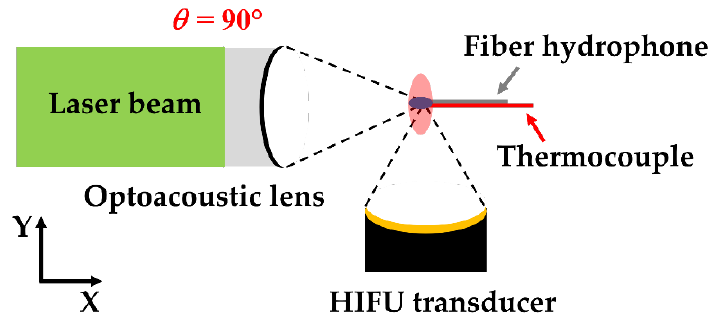
Figure 1. Experimental setup showing the superposition of LGFU and HIFU ( θ = 90 ◦ ); the focal zone of LGFU shown with the blue ellipse directed along the x -axis, and the focal zone of HIFU with the red ellipse along the y -axis).